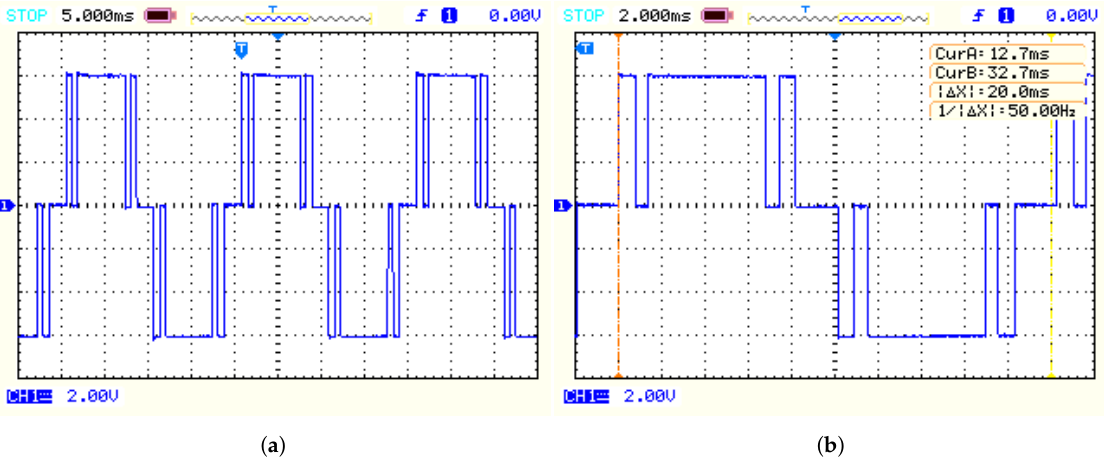
Figure 12. ( a ) Inverter output voltage without motor (No load); ( b ) Inverter Output voltage (one